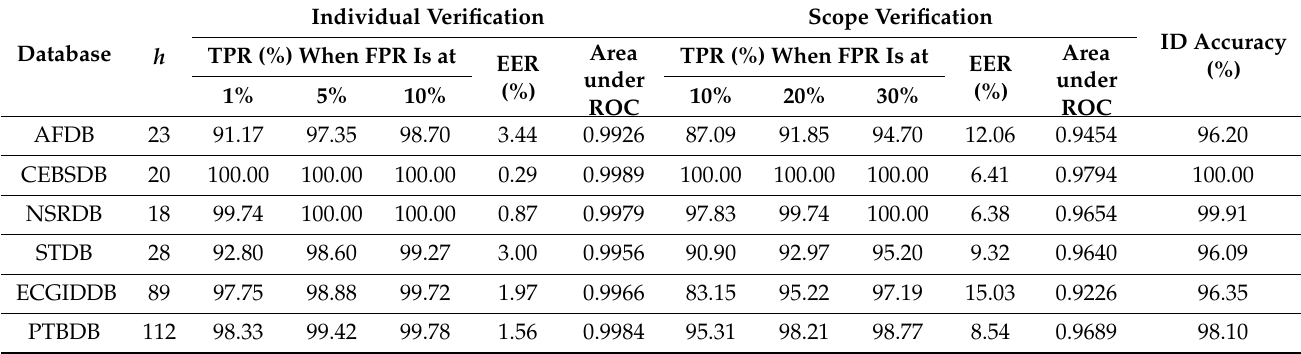
Table 10. Performance over short time separation. h: total number of people, TPR: true positive